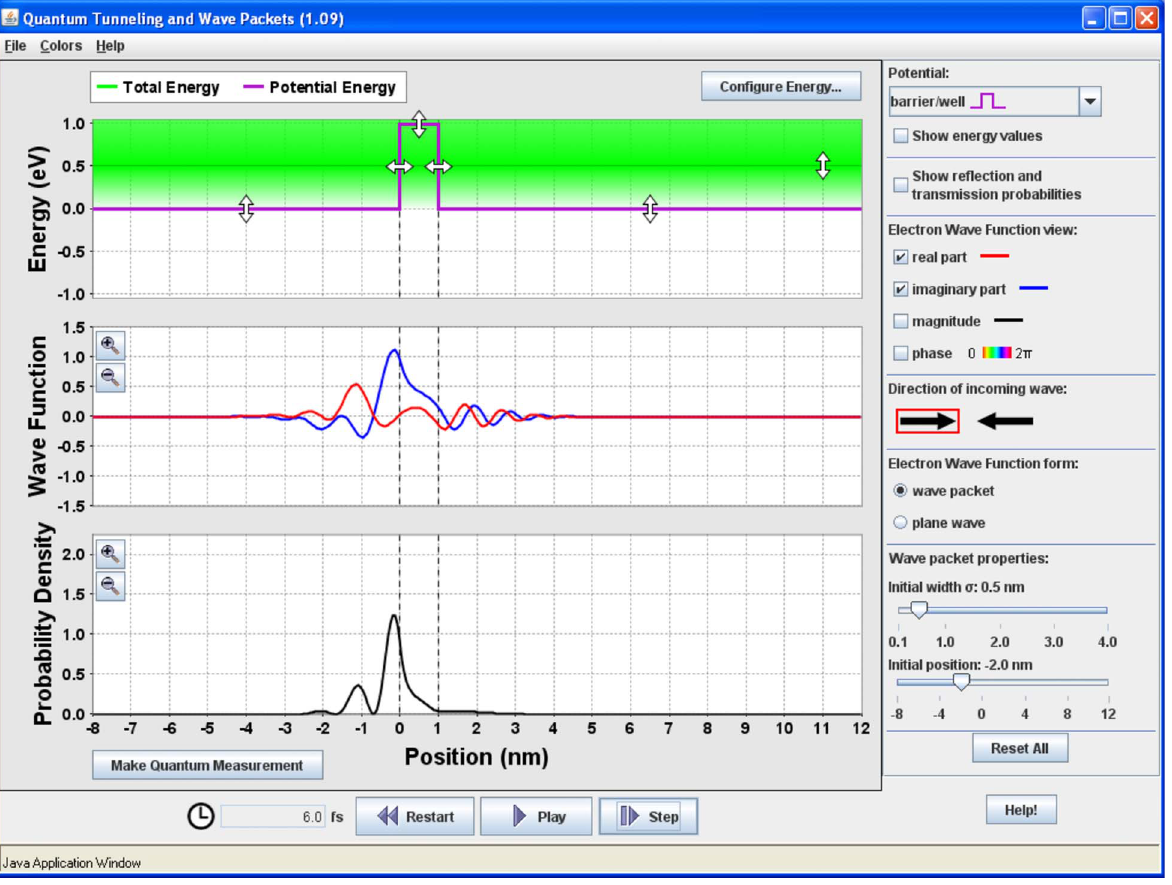
FIG. 5. (cid:1) Color (cid:2) The Quantum Tunneling and Wave Packets simulation provides interactive visual models of tunneling of wave packets and plane waves in a variety of physical situations and removes constraints imposed on curriculum by what problems can be easily